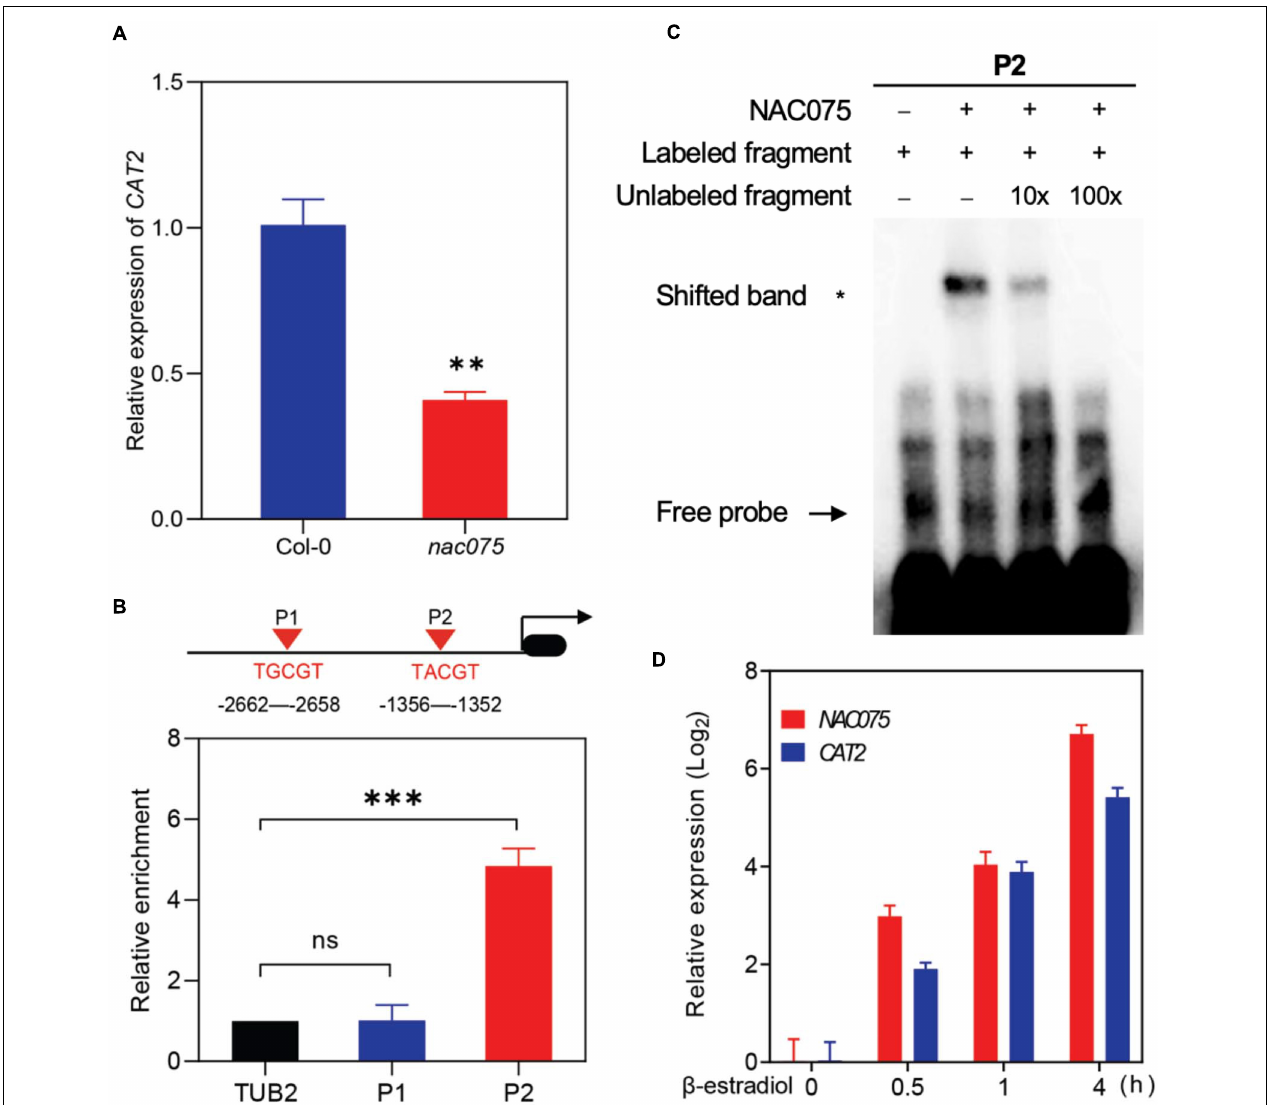
FIGURE 4 | CAT2 is a direct target of NAC075. (A) Relative expression level of CAT2 in the third and fourth rosette leaves of 25-day-old Col-0 and nac075 mutant plants. Data are means ± SD, n = 3. (B) NAC075 directly binds to the promoter of CAT2 . Schematic diagram indicates the locations of two putative NAC075 binding sites (P1 and P2) in the CAT2 promoter (top). ChIP-qPCR was performed to examine the relative NAC075 binding to the CAT2 promoter (bottom). An anti-GFP monoclonal antibody was used for DNA immunoprecipitation from 28-day-old Pro35S:NAC075-GFP /Col-0 transgenic plants. The relative enrichment of NAC075 binding to CAT2 promoter was normalized to TUBULIN2 ( TUB2 ). Student’s t- test, ∗∗ P < 0 .01, ∗∗∗ P < 0.001, ns, not significant. Data are means ± SD of three independent biological replicates. (C) EMSA assay of the binding of NAC075 to the CAT2 promoter in vitro . Biotin-labeled probe was used to EMSA experiment and non-labeled fragments were used as competitors. The + and − symbols represent the presence and absence of components. Three biological replicates were performed with similar results. (D) qRT-PCR analysis of NAC075 and CAT2 expressions in the pER8-FLAG-NAC075 plants treated with 50 mM β -estradiol for the indicated time points. Data are represented as means ± SD, n =